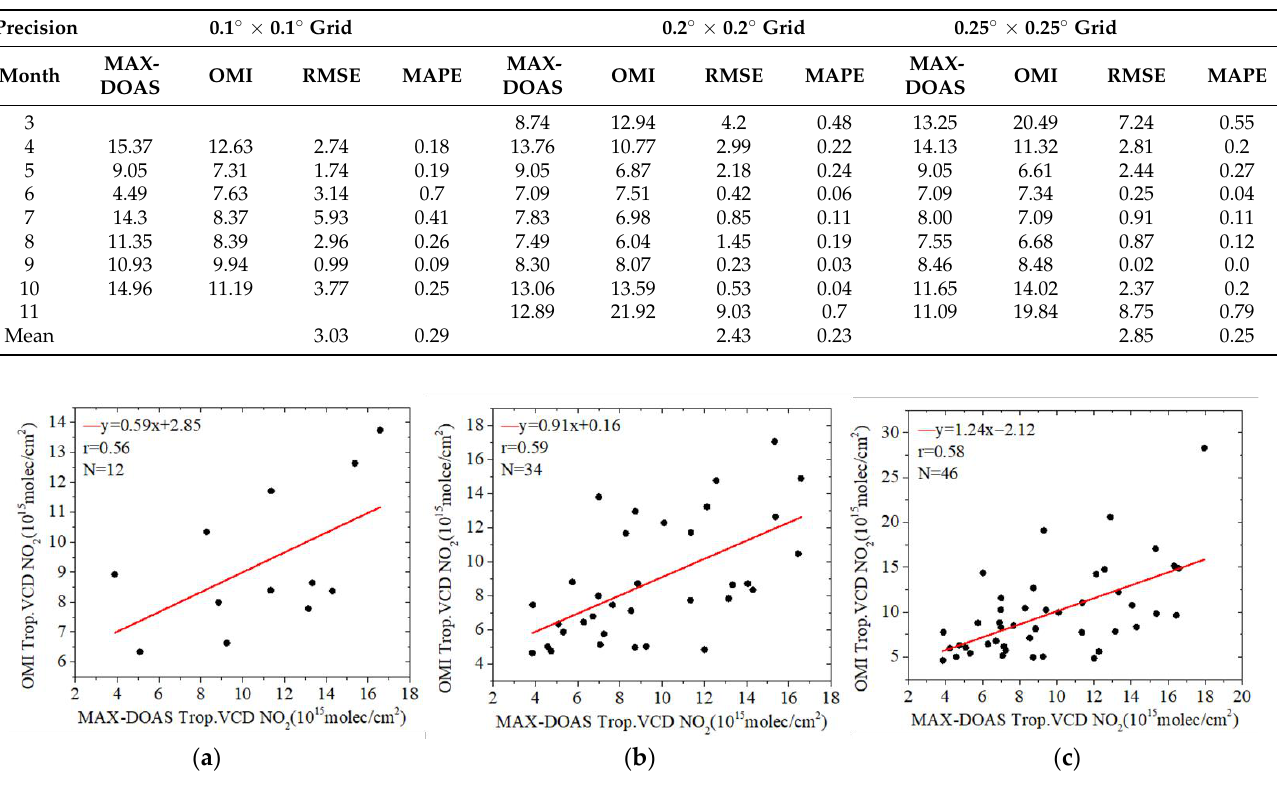
Figure 9. Comparison of the daily averaged MAX-DOAS and OMI in the different matching grids in 2019. ( a ) 0.1° grid, ( b ) 0.2° grid, and ( c ) 0.25° grid.